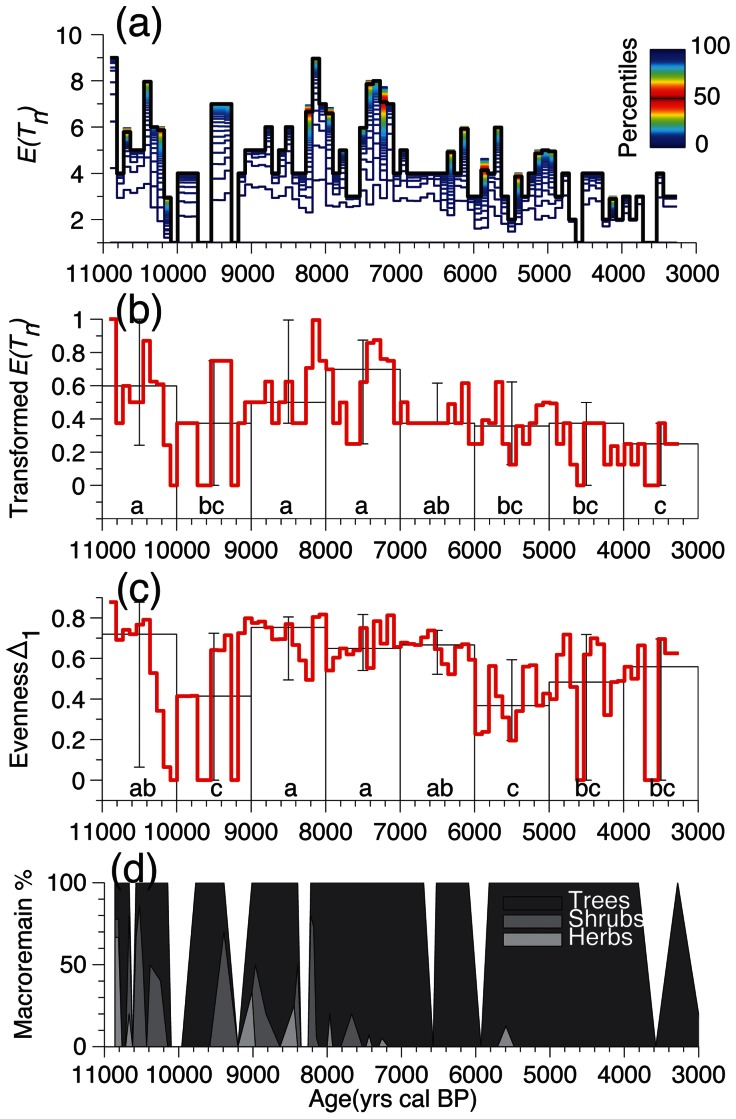
Macroremain richness E(Tn) inferred based on the rarefied and resampled pollen record from Lac de Fully.(a) E(Tn) of all 500 simulations with median as black continuous line and percentiles (see legend) as coloured lines. (b) Minimax rescaled median E(Tn). (c) Evenness (Δ1) based on the probability of interspecific encounter. The bars in (b) and (c) indicate the median E(Tn) and Δ1 for 1000-years windows, vertical whiskers indicate the full range of E(Tn) and Δ1 in each time period; letters (a-c) illustrate significant differences from the post hoc least significant difference tests (two different letters indicate a significant difference at the p = 0.05 level). (d) Cumulative macroremain percentages of trees, shrubs and herbs.